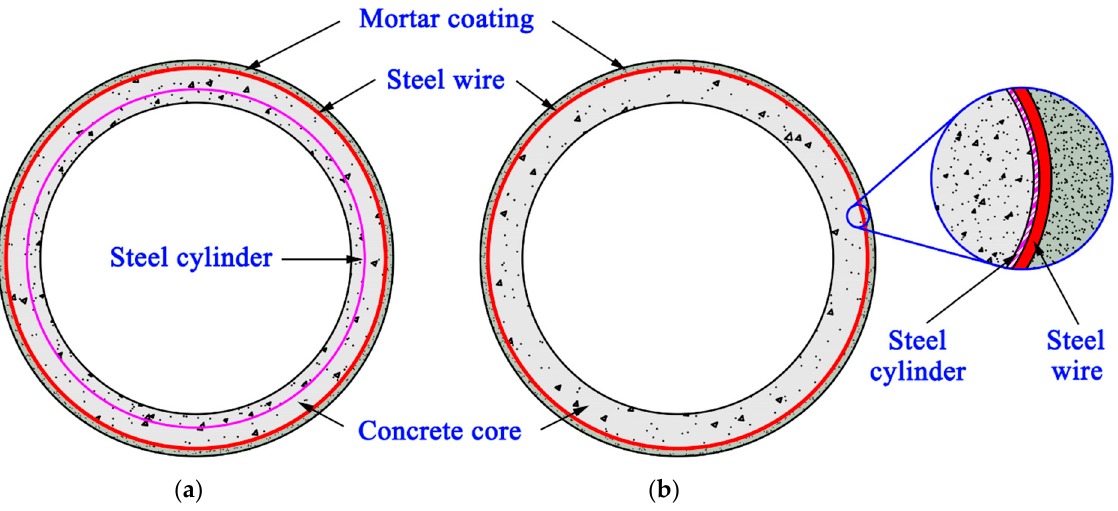
Figure 1. Cross section composition of PCCP: ( a ) embedded steel cylinder; and ( b ) lined steel cyl-